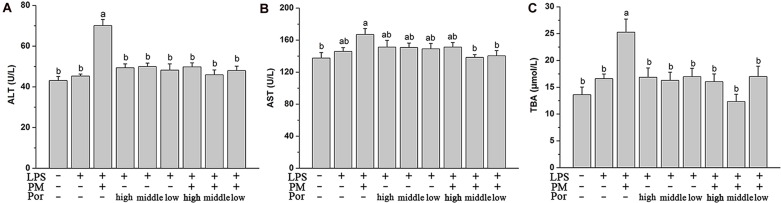
The Plasma biochemical indicators in different dose of Poria compatible test, specifically shown as control group (Ctr), LPS model group (LPS), PM treated with LPS group, high dose of Poria treated with LPS group, middle dose of Poria treated with LPS group, low dose of Poria treated with LPS group, PM + high dose of Poria co-treated with LPS group, PM + middle dose of Poria co-treated with LPS group, PM + low dose of Poria co-treated with LPS group. Rats were firstly treated with different compatible proportion of herbs before three hours received LPS 2.8 mg/kg at caudal vein. (A,B) Blood samples were taken at 7 h after the administration of LPS, and plasma ALT and AST levels were measured. (C) Plasma TBA content were measured in the same conditions. The results were expressed as mean ± SEM (n = 9). Mean values followed by the same letter are not significantly different (P < 0.05) as determined by Duncan’s multiple-range test.